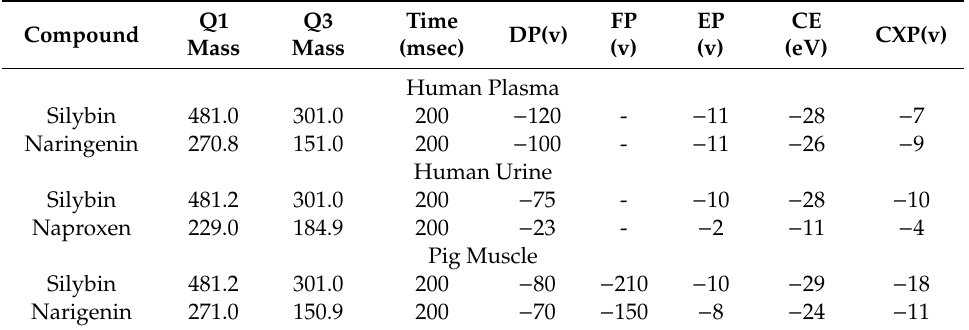
Table 6. Mass spectrometer parameters for monitoring silybin and internal standards in human plasma, human urine, and pig muscle analyses. FP EP CE Q1 Q3 Time CXP(v) DP(v) Compound (v) (v) (eV) Mass Mass (msec) Human Plasma Silybin 481.0 301.0 200 − 120 - − 11 − 28 − 7 Naringenin 270.8 151.0 200 Human Urine Silybin 481.2 301.0 200 − 10 Naproxen 229.0 184.9 200 − 23 Pig Muscle Silybin 481.2 301.0 Narigenin 271.0